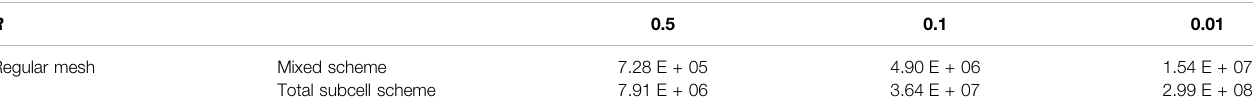
TABLE 4 | Condition numbers of Jacobian matrix with different partition ratios.